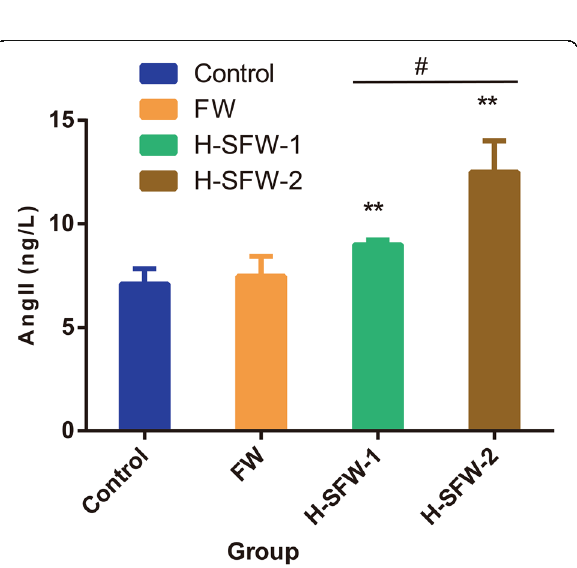
Fig. 3 Effects of different concentrations of NaCl in drinking water on Ang II content in vascular smooth muscle of broilers. ( n = 10, ** P < 0.01 vs. control, # P < 0.05 H-SFW-1 vs.